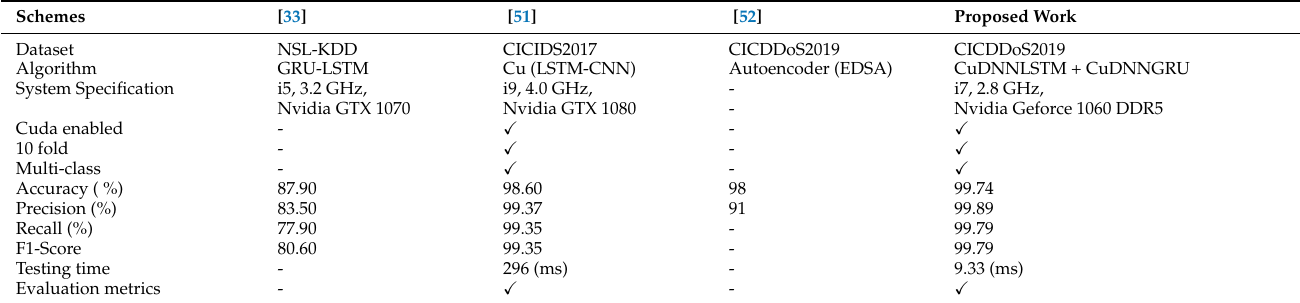
Table 4. Comparison with current benchmarks. GRU-LSTM: gated recurrent unit–long short-term memory.